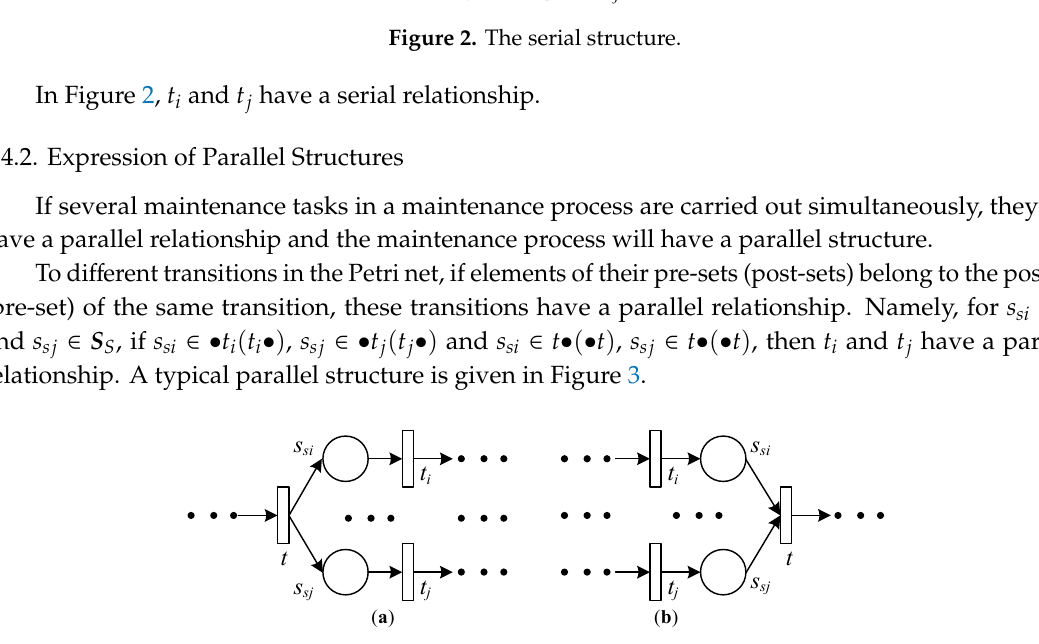
Figure 3. The parallel structure. ( a ) several maintenance tasks start simultaneously; ( b ) several maintenance tasks end